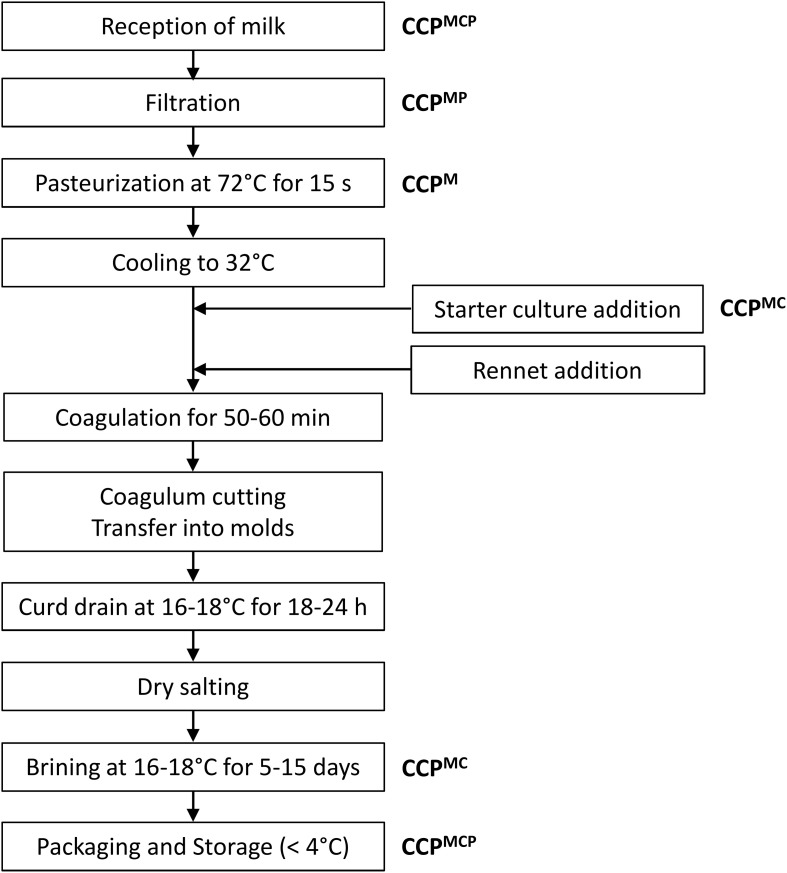
Flow-chart of Feta cheese production with indicated Critical Control Points (CCP) of the microbiologicalM, chemicalC and physicalP hazards [modified from Mauropoulos and Arvanitoyannis (1999); Tamime et al. (2007) and El-Hofi et al. (2010)].